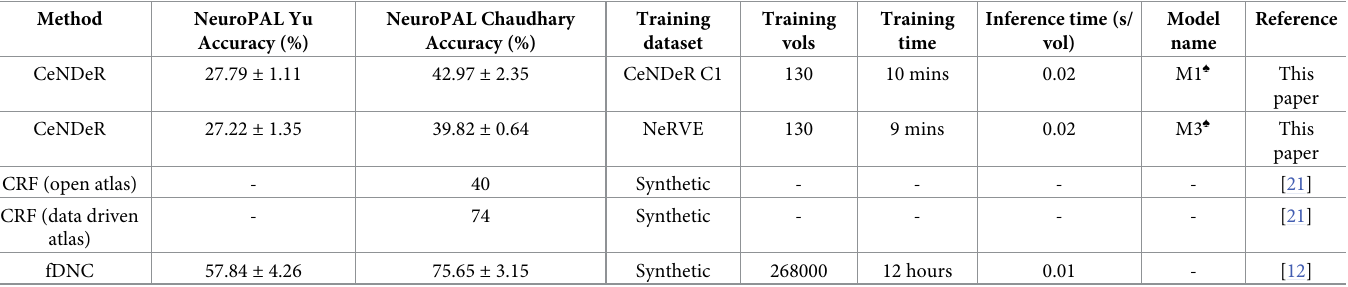
Table 5. Cell-type IDs recognition. We summarize and compare the performances of CeNDeR with CRF and fDNC when tested on NeuroPAL strains. Selecting different template volumes would produce variable recognition results. Here, we present the mean and standard deviation of the recognition accuracy. We reevaluated fDNC results using their given model. “s/vol” refers to seconds per volume.